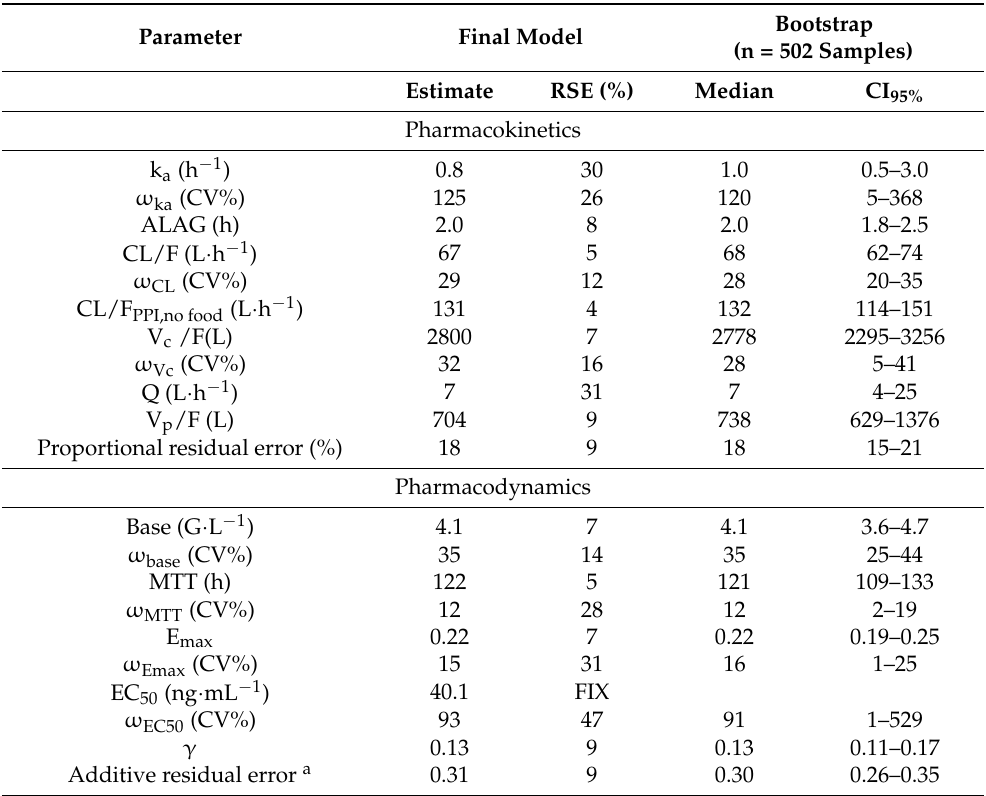
Table 2. Parameter estimates in the final PK/PD model with bootstrap